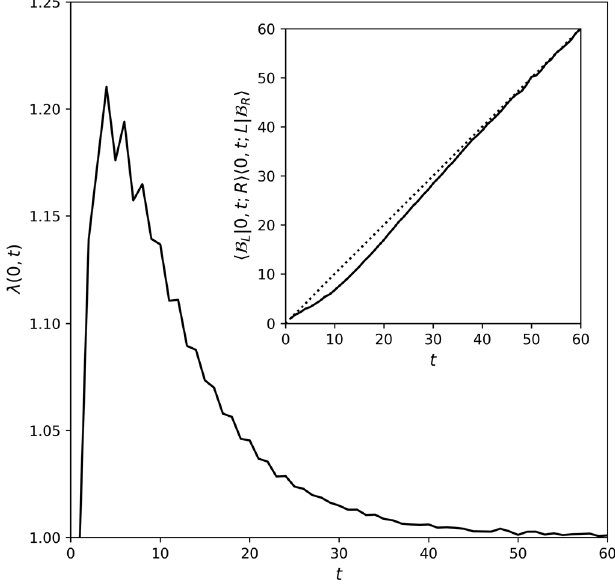
FIG. 10. Leading eigenvalue λ ð 0 ; t Þ of the average transfer ¯ T ð t Þ matrix . In the inset, the solid line shows the overlap of the corresponding eigenvectors with the boundary states j B L;R i , which approaches t (dotted) at late